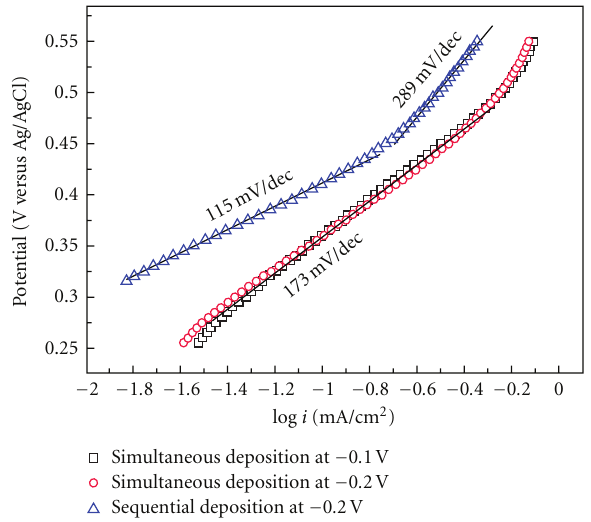
Figure 8: Tafel plots of anode polarization curve in 1.0 M methanol and 0.5 M H 2 SO 4 solution for ( (cid:2) ) simultaneous deposition at − 0.1V, ( ◦ ) simultaneous deposition at − 0.2 V, and ( (cid:3) ) sequential deposition at − 0.2 V (reprinted with permission from